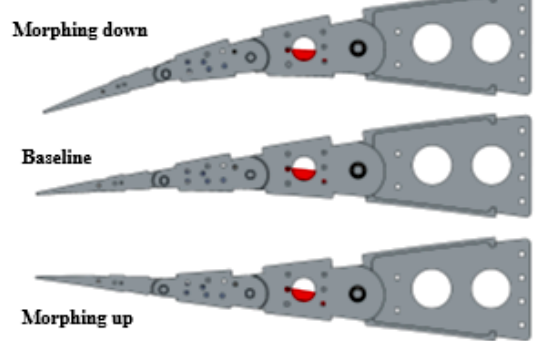
Figure 3. Two-bay trailing edge architecture: hidden skin.